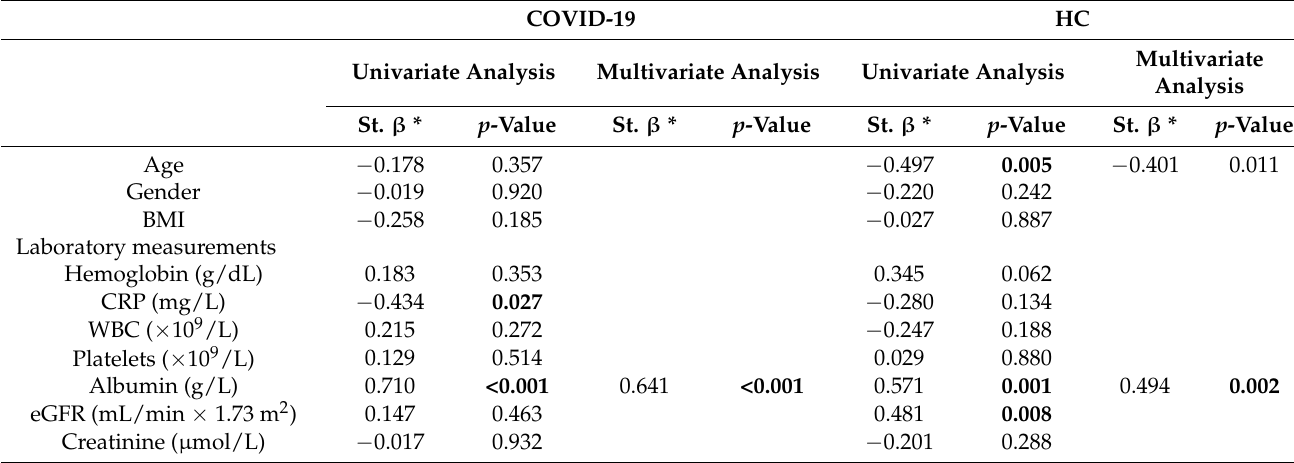
Table 2. Univariable and multivariable linear regression analyses of serum free thiol concentrations with clinical and biochemical parameters in COVID-19 subjects and healthy controls.